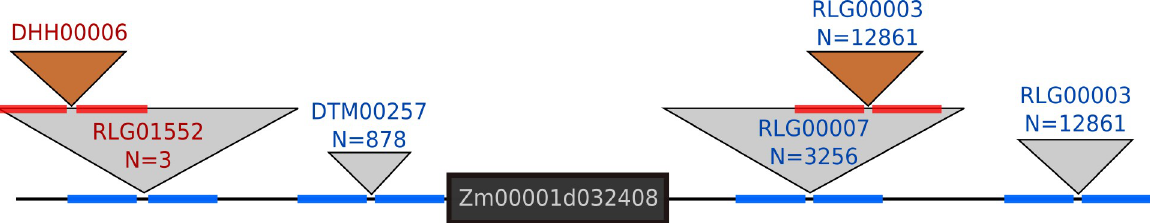
Fig 1. A region on chromosome 1 of the B73v4 genome from 225,749,884bp to 225,830,165bp is displayed as a schematic of genes (rectangles) and TEs (triangles). All TEs are labeled with their TE family name and family size with red text indicating small families ( < 20 members) and blue text indicating large families ( > = 20 members). Nested (within another TE) and non-nested elements are shown in orange and grey respectively. Flanking regions are identified by color based on whether they are outside of other TEs (blue) or located within other TEs (red). Flanking regions within other TEs are excluded from our